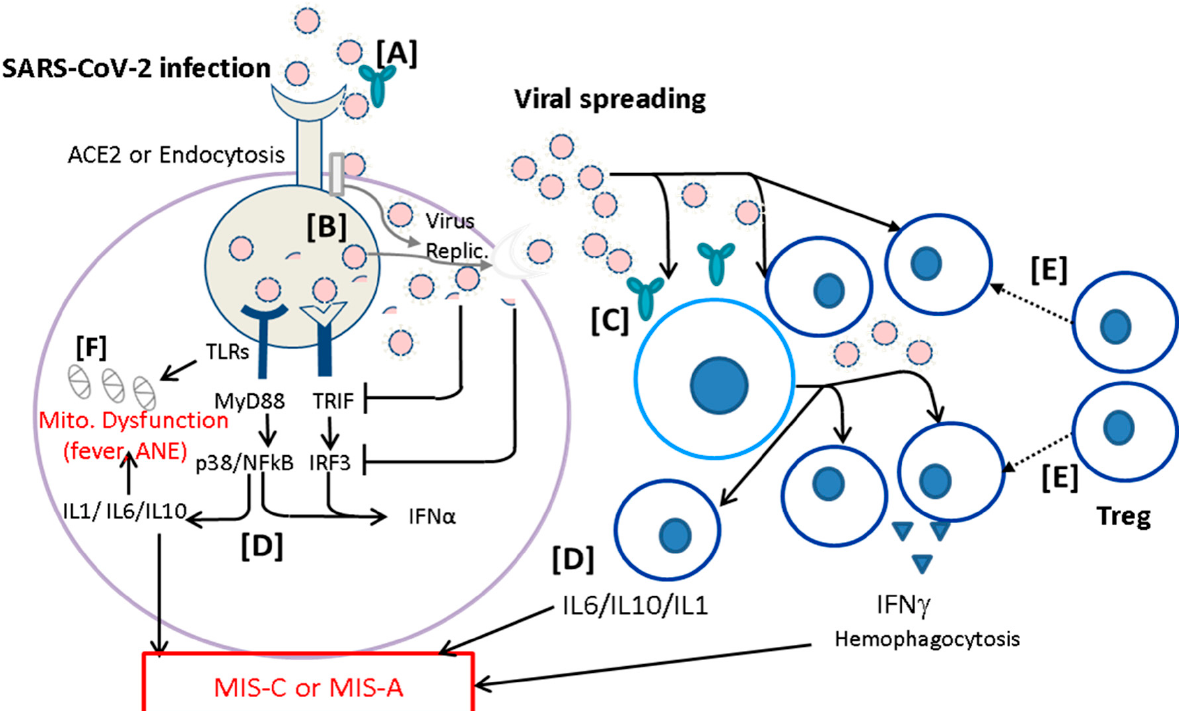
Figure 3. Prevention of severe non-pulmonary COVID-19 diseases. A COVID-19 disease is usually induced by SARS-CoV-2 infection, followed by viral spreading while innate immunity cannot limit the virus replication (Virus Replic.). Patients with certain genetic variants might cause malignant fever and mitochondrial (Mito.) dysfunction, associated with hyperinflammation resulting in acute necrotizing encephalopathy (ANE) in deep brain regions. The viral spreading can be interrupted by adaptive immunity such as T cell immunity resulting in recovery. Altered immune reactions could lead to ( → ) cytokine storm or T cell overactivation such as production of IFN γ and hemophagocytosis under impairment of T regulatory cells (Treg), resulting in MIS-C or MIS-A. Based on the altered infection immunity proposed here, we could prevent the severe non-pulmonary diseases as follows: [A] virus neutralization by active and passive immunization for limiting viral transmission by effective neutralizing antibodies; [B] anti-virus replication (Virus Replic.) by small molecules, such as paxlovid or remdesivir; [C] early reduction of viral load by monoclonal antibodies or trispecific DARPin; [D] targeting altered immune reaction and cytokine storm by inhibition of leukocyte activation; [E] immunoregulation ( ) of altered inflammation by enhancement of regulatory T cells (Treg) through administration of IVIG, methylprednisolone, or mesenchymal stem cells; and [F] avoiding mitochondrial (Mito.) dysfunction by controlling fever and early supplying mitochondrial cocktails including biotin, thiamine, L-carnitine, and CoQ10. 6.1. Virus Neutralization by Active and Passive Immunization Given the safety consideration, vaccine availability for children, particularly for in- fants, is authorized late, so the herd immunity in adults is important for protecting infants and children from infections. Similarly, passive immunization with specific monoclonal antibodies is also authorized late for children and infants. Although the SARS-CoV-2 has evolved into immune escape of vaccines and monoclonal antibodies, the current vaccines remain effective on reducing morbidity and mortality. In the COVID-19 pandemic, family contacts are more important than school contacts for the social distancing in family is much shorter than those in schools, especially while a school policy restricts affected chil- dren from school. The herd immunity in the household (family and daycare centers) would be important for providing protection of children from COVID-19. In addition, since application of monoclonal antibodies and anti-virus drugs are limited for small chil- dren, it is also important to prepare a convalescent plasma with high neutralizing anti- body titers directed against homologous virus variant for preventing infants and children with immunodeficiency or immunocompromised situation from severe COVID-19. For newborns and premature babies, the prevention of COVID-19 should be started from maternal vaccination. Pregnant mothers should have a full course of vaccination with the boosting dose in the third trimester, which will ensure the effective neutralizing